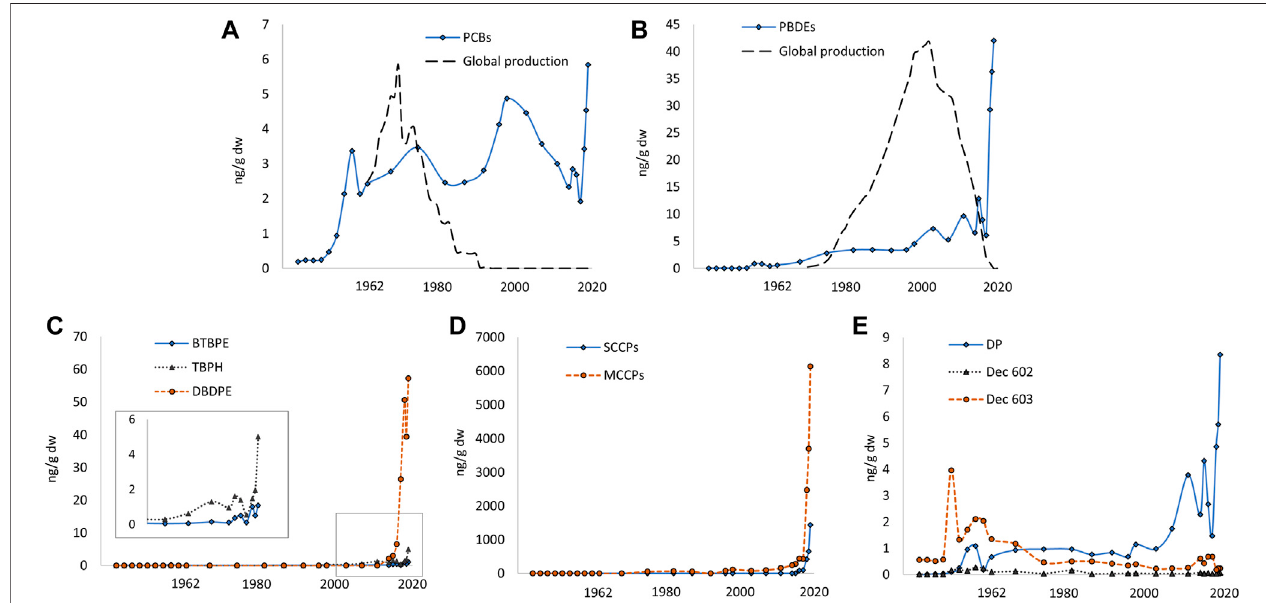
FIGURE2|A , B) Concentrationof (cid:1) 32 PCBsand (cid:1) 25 PBDEs,respectively,insedimentslayersdatedfrombefore1962 – 2019,alongwithtrendinglobalproduction for PCBs from Breivik et al. (2002), and trend in global production for PBDEs from Abbasi et al. (2019). (C – E) Concentration of aBFRs, CPs, and dechloranes, respectively, in sediments layers dated from before 1962 –